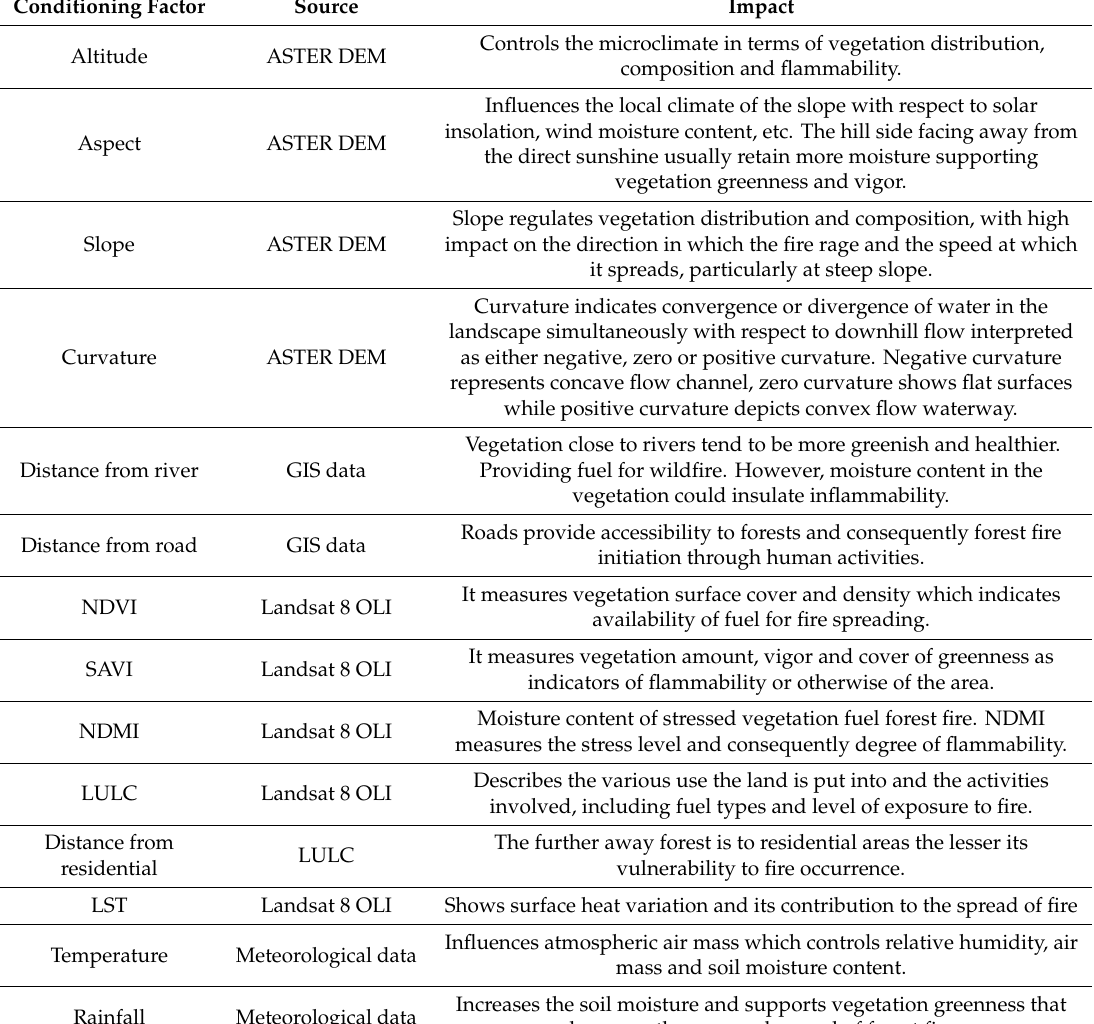
Table 1. Spatial dataset and data